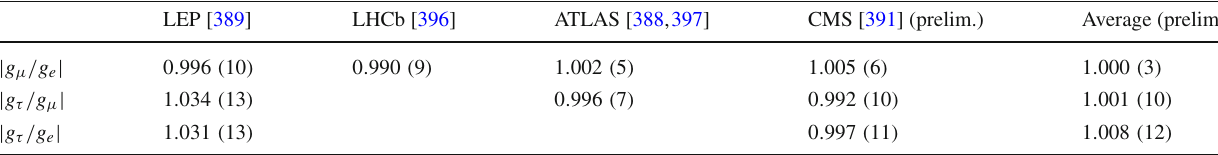
Table 2 Experimental determinations of the ratios g (cid:2) / g (cid:2) (cid:5) from W → (cid:2) ¯ ν (cid:2)